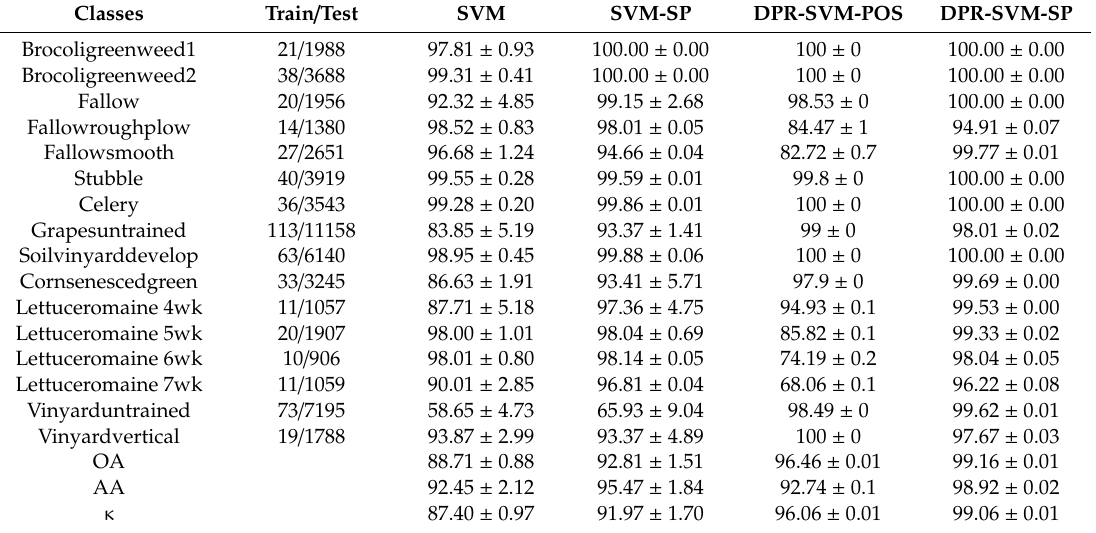
Table 4. Statistical results (mean and standard deviation in percent) of 10 independent classifications provided by SVM, SVM-SP, DPR-SVM-POS and DPR-SVM-SP on Salinas datasets with 1% labeled samples per class, s = 15 and β = 0.9.